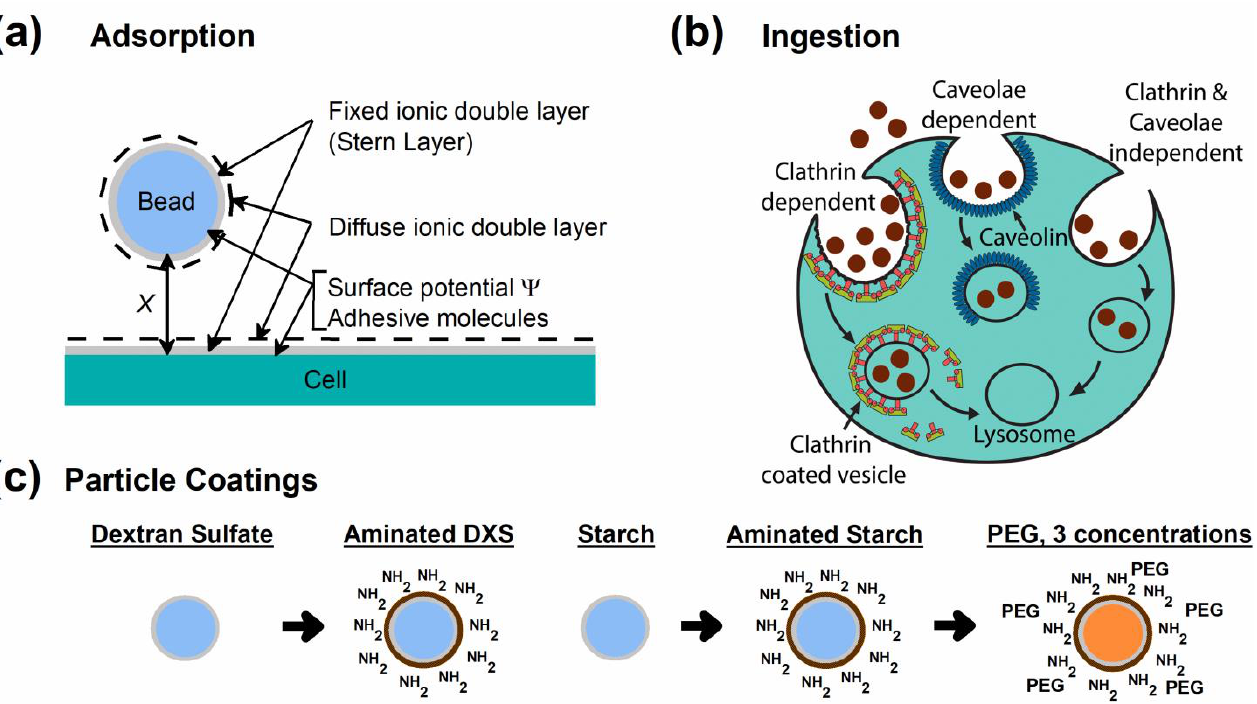
Figure 1. Steps of endocytosis and coatings of nanoparticles. ( a ) The adsorptions step depends on the interactions of the ionic double layers and adhesive molecules on the particle and cell surfaces. The depth of the (repulsive) diffuse double layer is reduced by increased ionic strength, allowing adhesive molecules to interact by Van Der Waals attraction. The zeta potential (ZP) is the